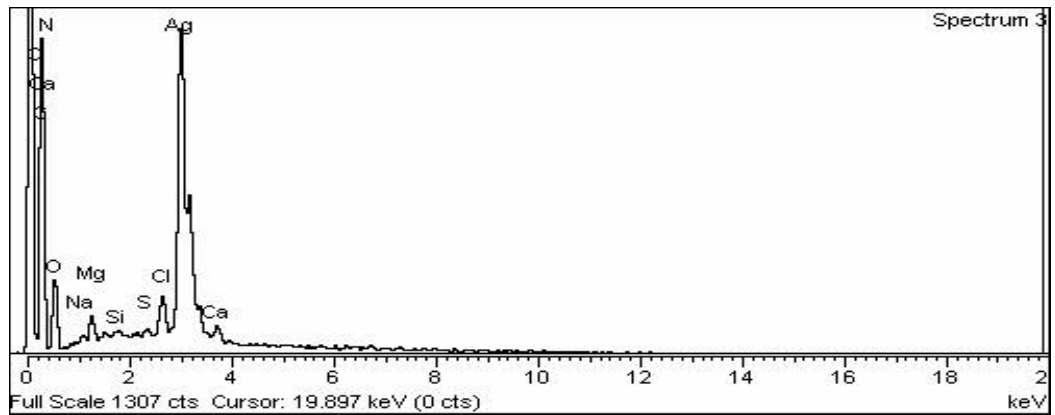
Figure 4. SEM image of T. couneifolia AgNPs.